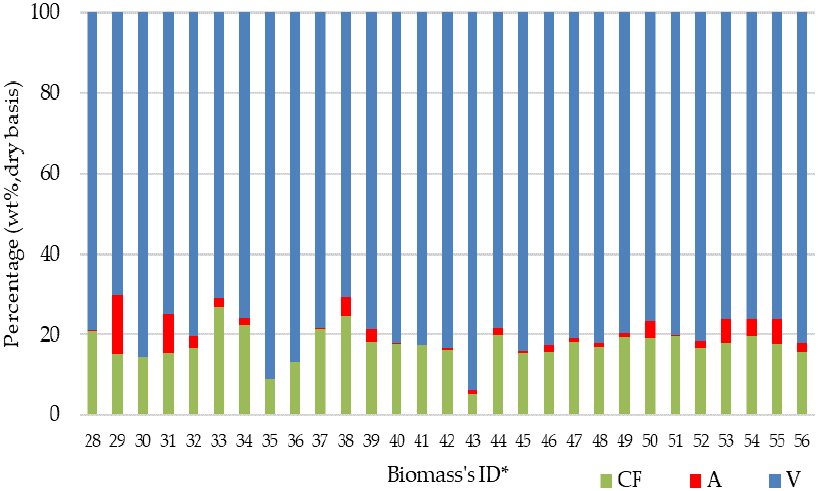
Figure 4. Results of proximate analysis for the Amazonian biomasses shown in Table 4 (wt. %, dry basis). * Biomass identification.